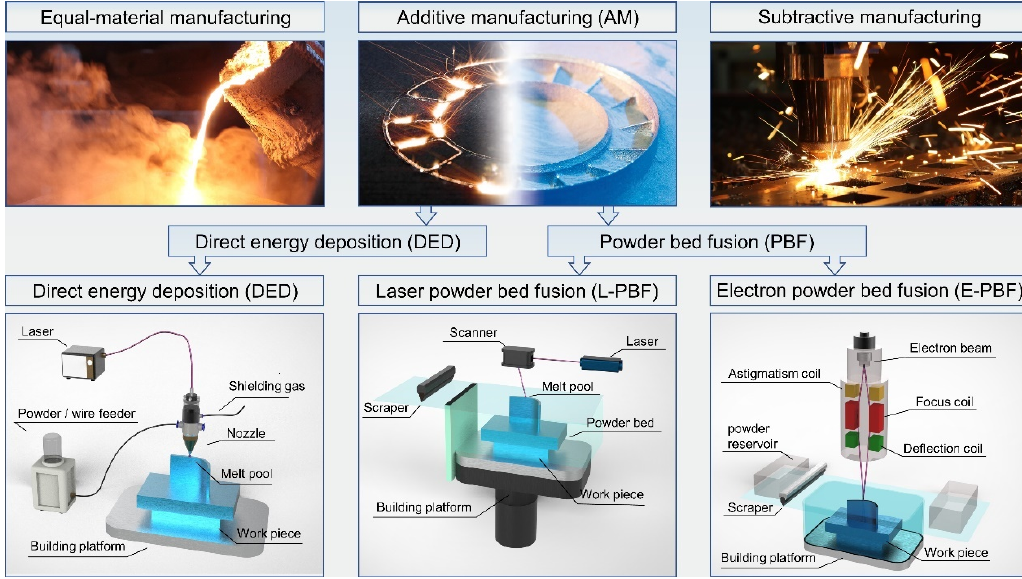
Figure 1. Classification of metal manufacturing processes: equal-material manufacturing, additive manufacturing [22], subtractive manufacturing.